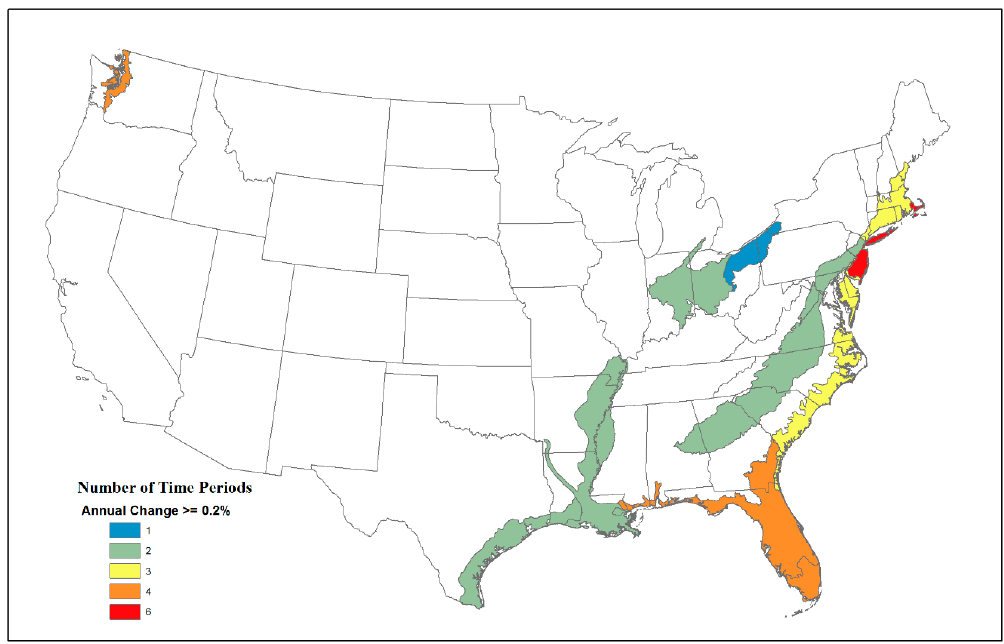
Figure 5. Ecoregions reaching or exceeding the rate of 0.2% annual forest to developed land cover change in any or all time intervals. Table 3. Ecoregions reaching or exceeding the rate of 0.2% annual forest to developed land cover change in any or all time intervals (all time intervals in